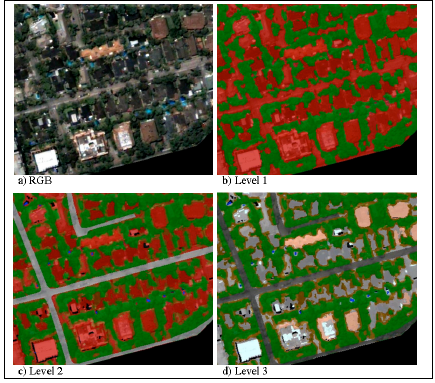
Figure 5. Land cover classification on different